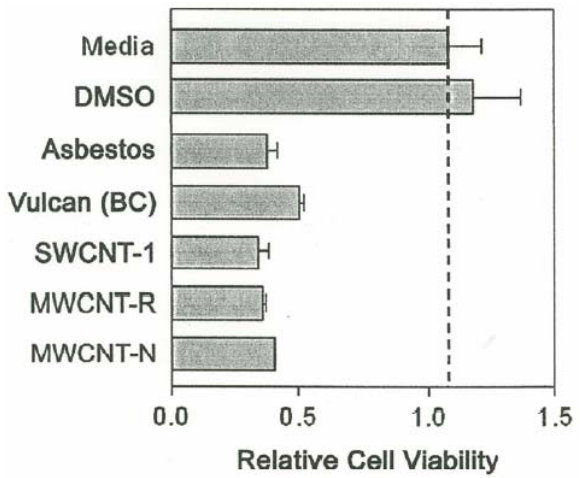
Figure 7: Comparative cytotoxicities of carbonaceous nanoparticulate aggregates and chrysotile asbestos nanotube aggregates to murine macrophage cells referenced to the media and DMSO solutions at a concentration of 5µg/mL. The relative cell viability was measured by optical densitometry at 570 nm.